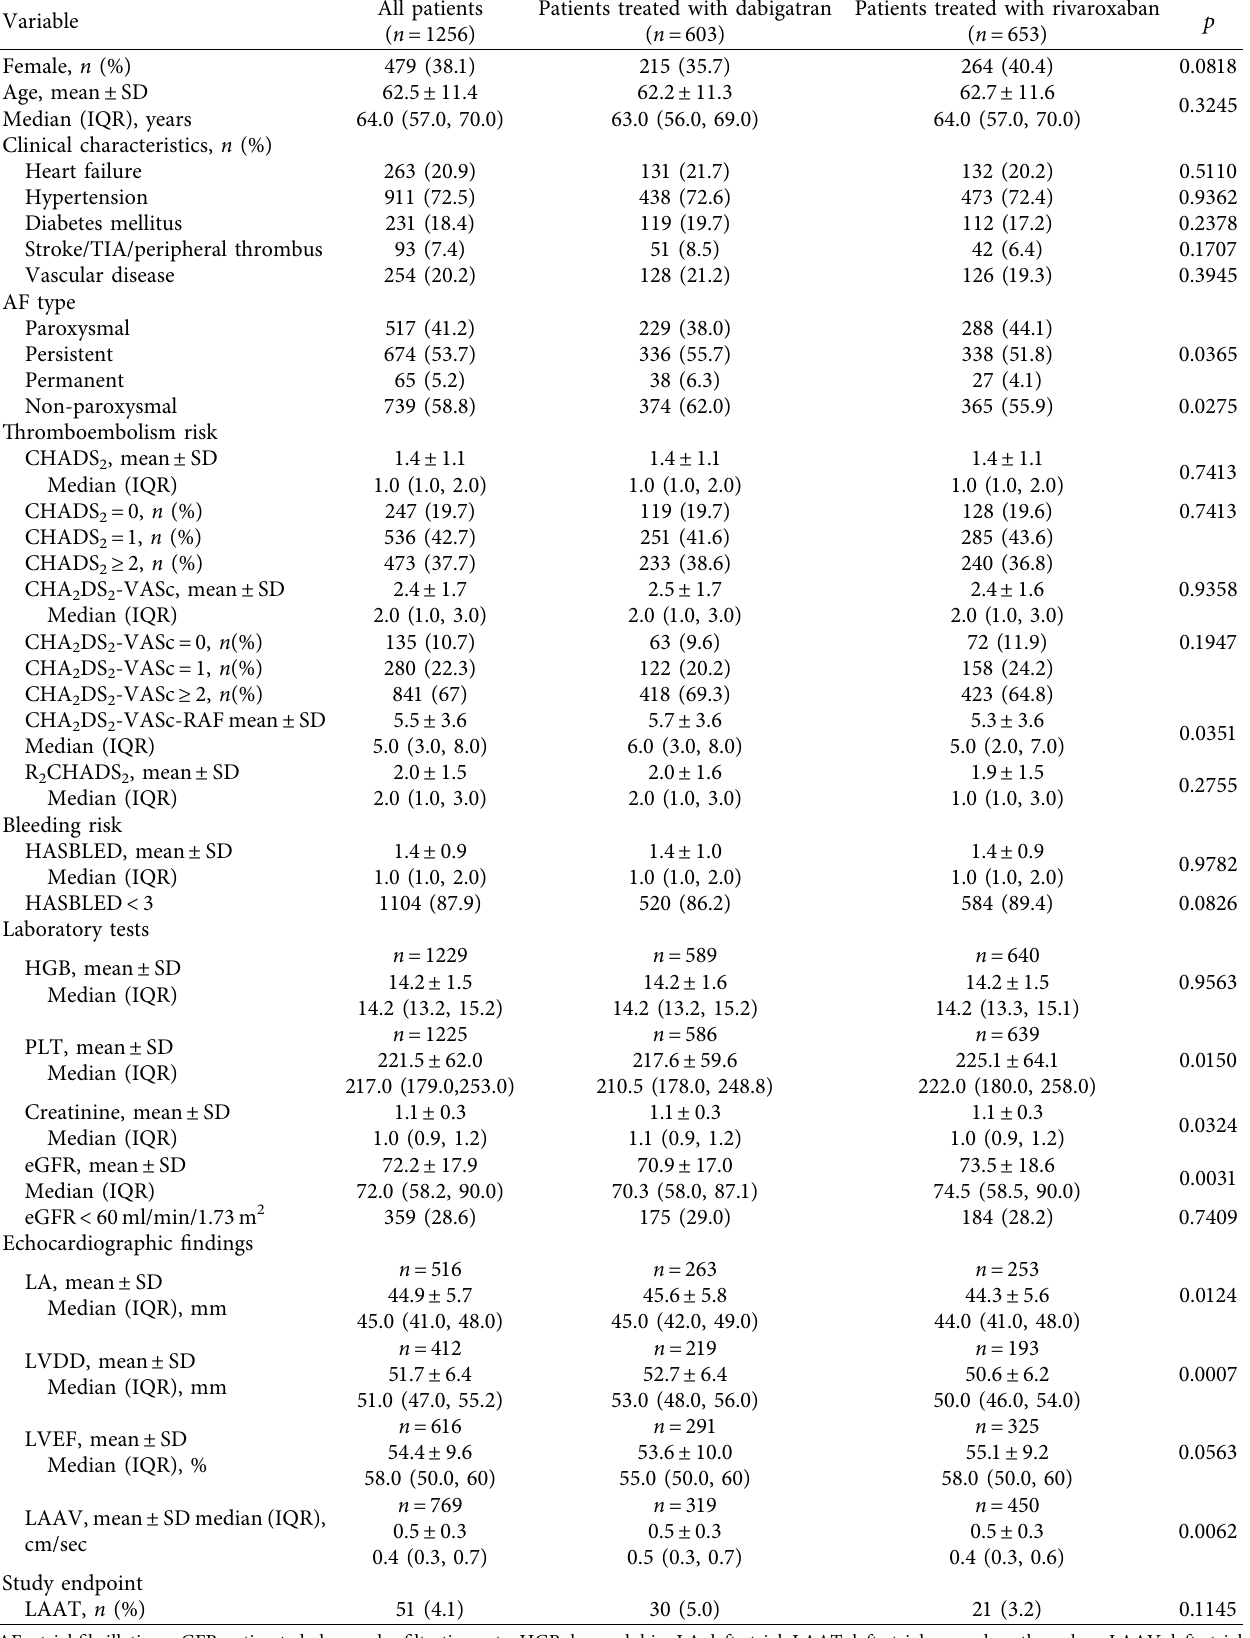
Table 2: Baseline characteristics of patient study